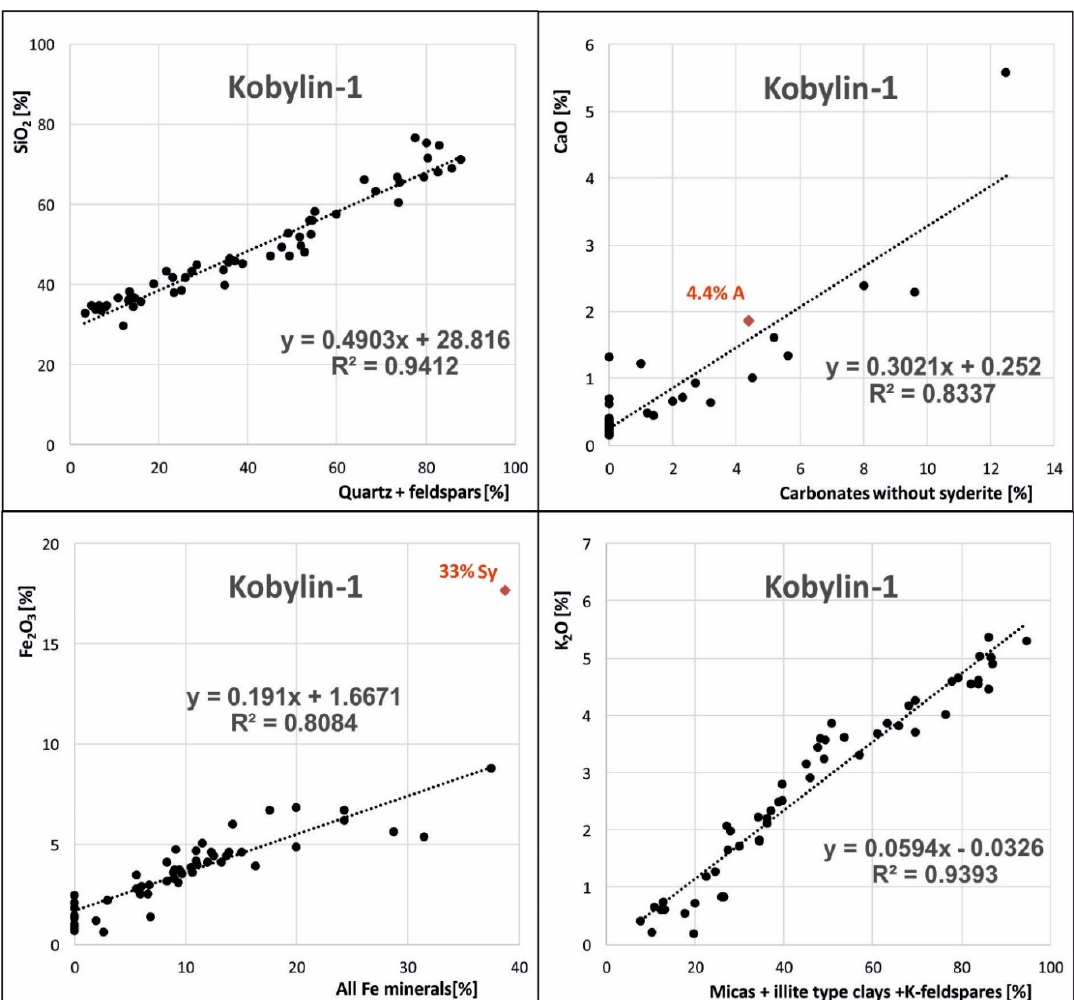
Figure 9. A model combining the contents of different mineral components with the contents of particular elements (pXRF) for Carboniferous rocks from the Kobylin-1 borehole. Explanations: Fe—